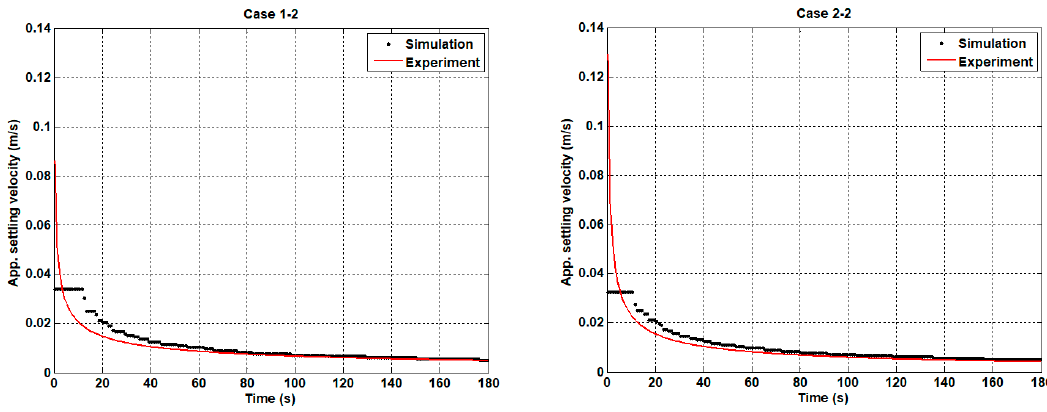
Figure 8. Comparison of simulation versus experimental results.